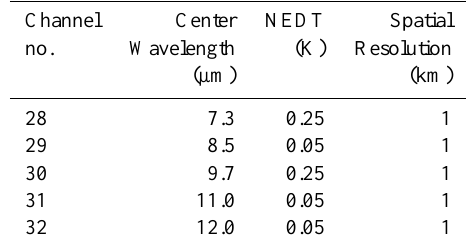
Table 1. MODIS TIR channels